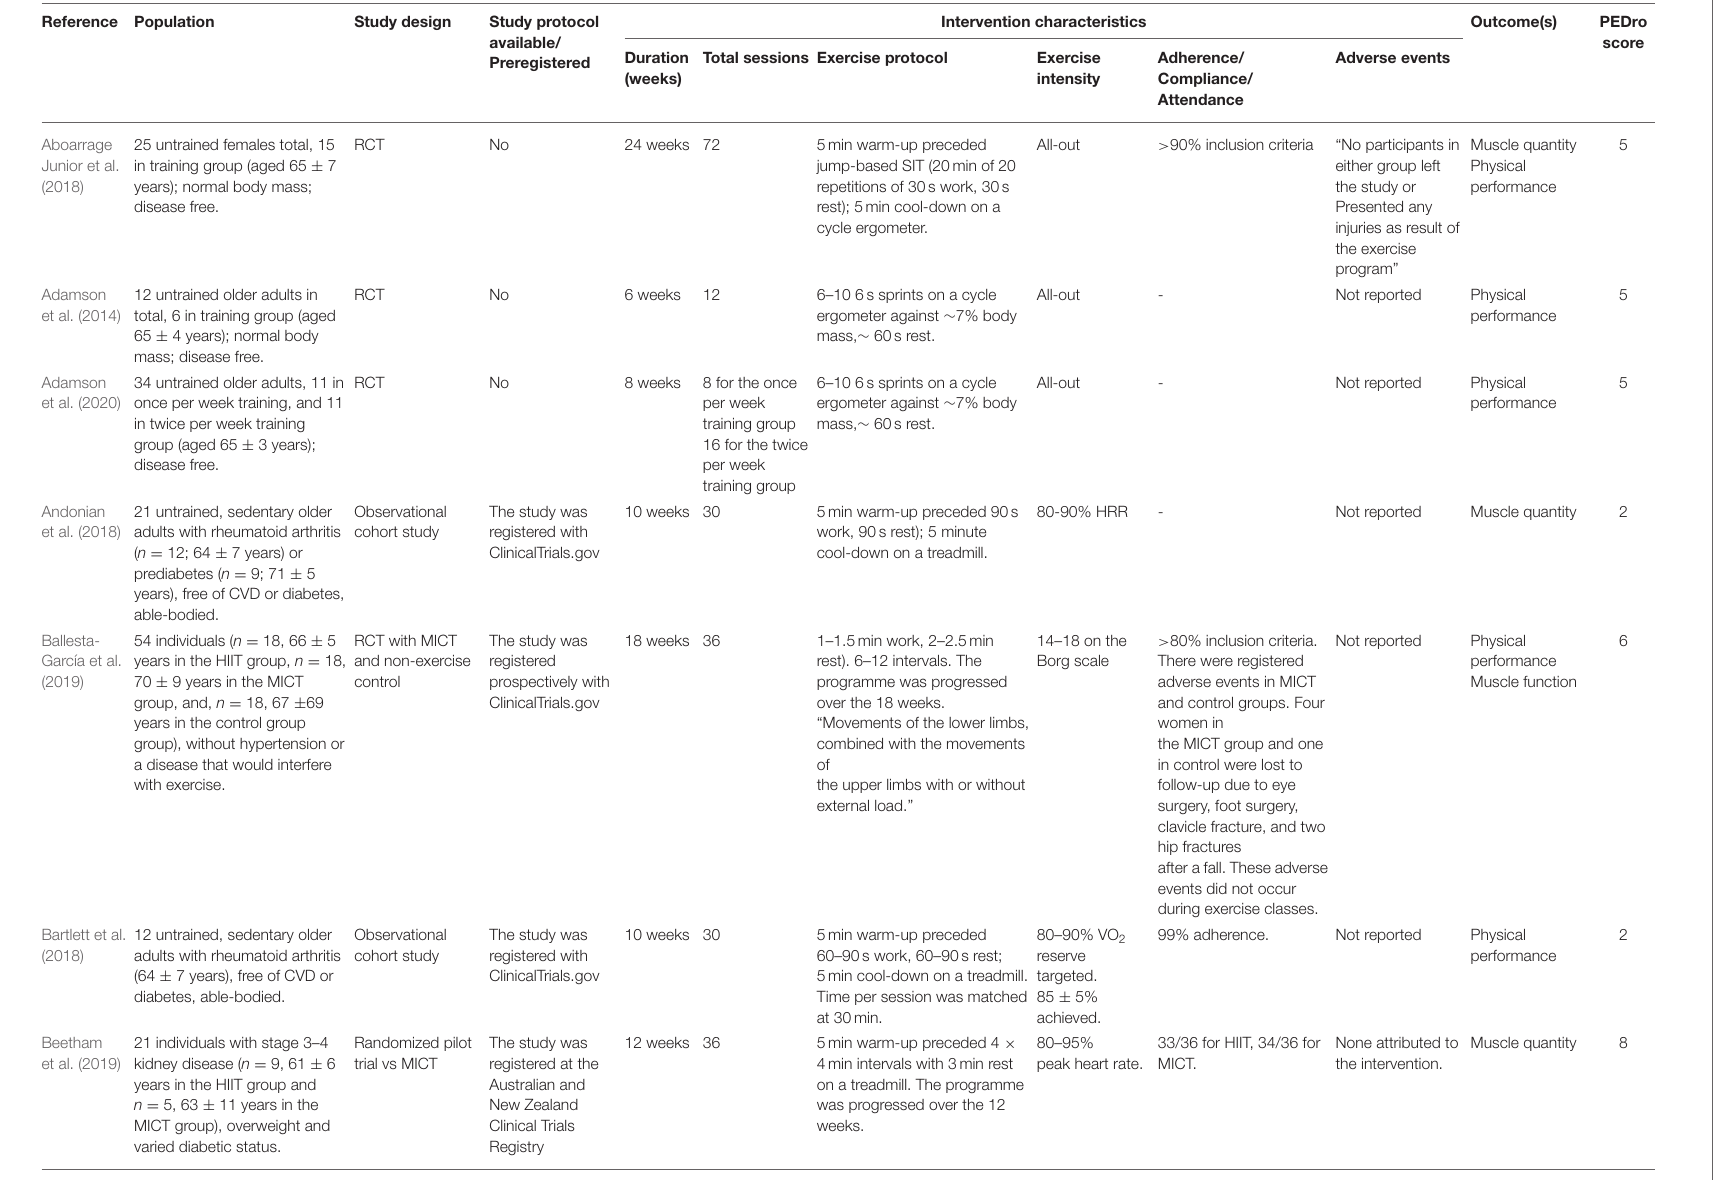
TABLE 1 | General study information of investigations concerning HIIT and phenotypic characteristics of